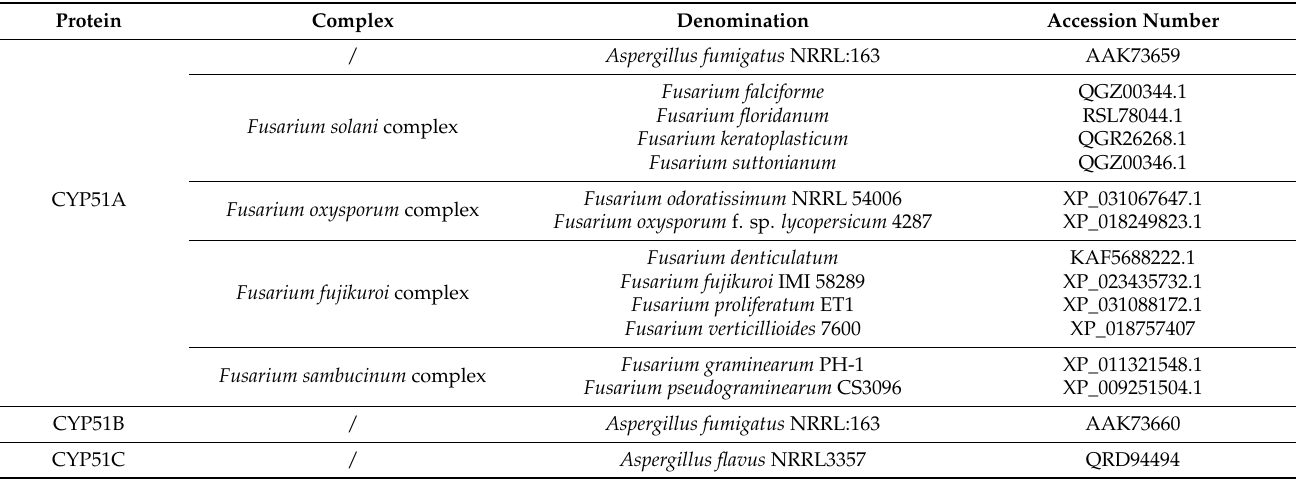
Table 3. Aspergillus sp. and Fusarium complex references and accession numbers of CYP51A, CYP51B, and CYP51C protein sequences used in our